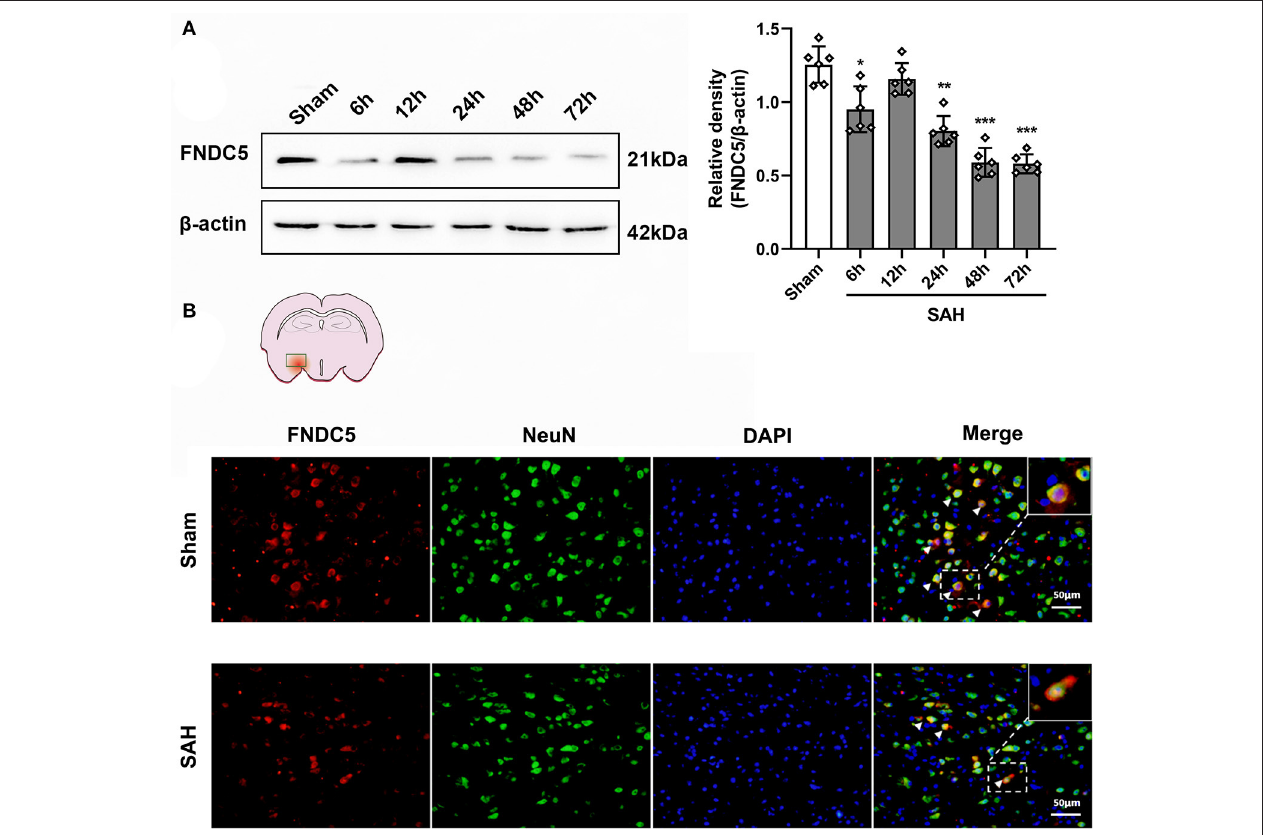
FIGURE 2 | Time course of FNDC5/irisin expression after SAH. (A) Representative western blotting images and relative density analysis of FNDC5/irisin at 6, 12, 24, 48, and 72h after SAH. Endogenous FNDC5/irisin protein decreased at 6h while it increased at 12h and decreased again from 24 to 72h after SAH. Data were represented as mean ± SD, n = 6 per group; the one-way ANOVA was used followed by the Tukey’s HSD post-hoc test and the Holm–Bonferroni correction method. * P < 0.05, ** P < 0.01, *** P < 0.001 vs. sham group. (B) FNDC5/irisin could be co-localized with neurons, and the number of FNDC5/irisin-positive neurons was decreased at 24h after SAH. Scale bar = 50 µ m, n = 3 per group; FNDC5, fibronectin domain-containing protein 5; SAH, subarachnoid